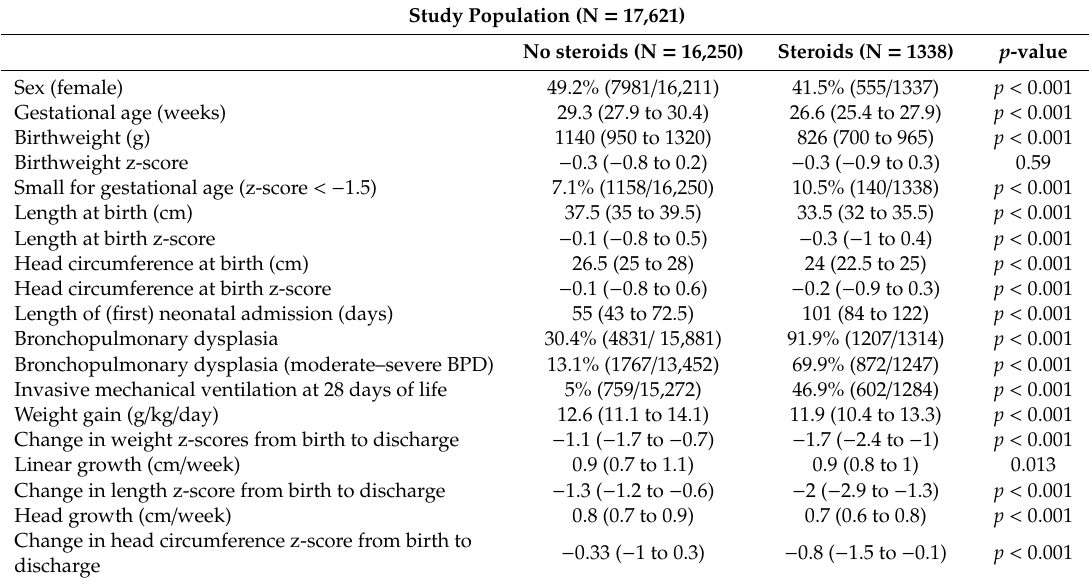
Table 1. Epidemiological, clinical and growth features of the study population.